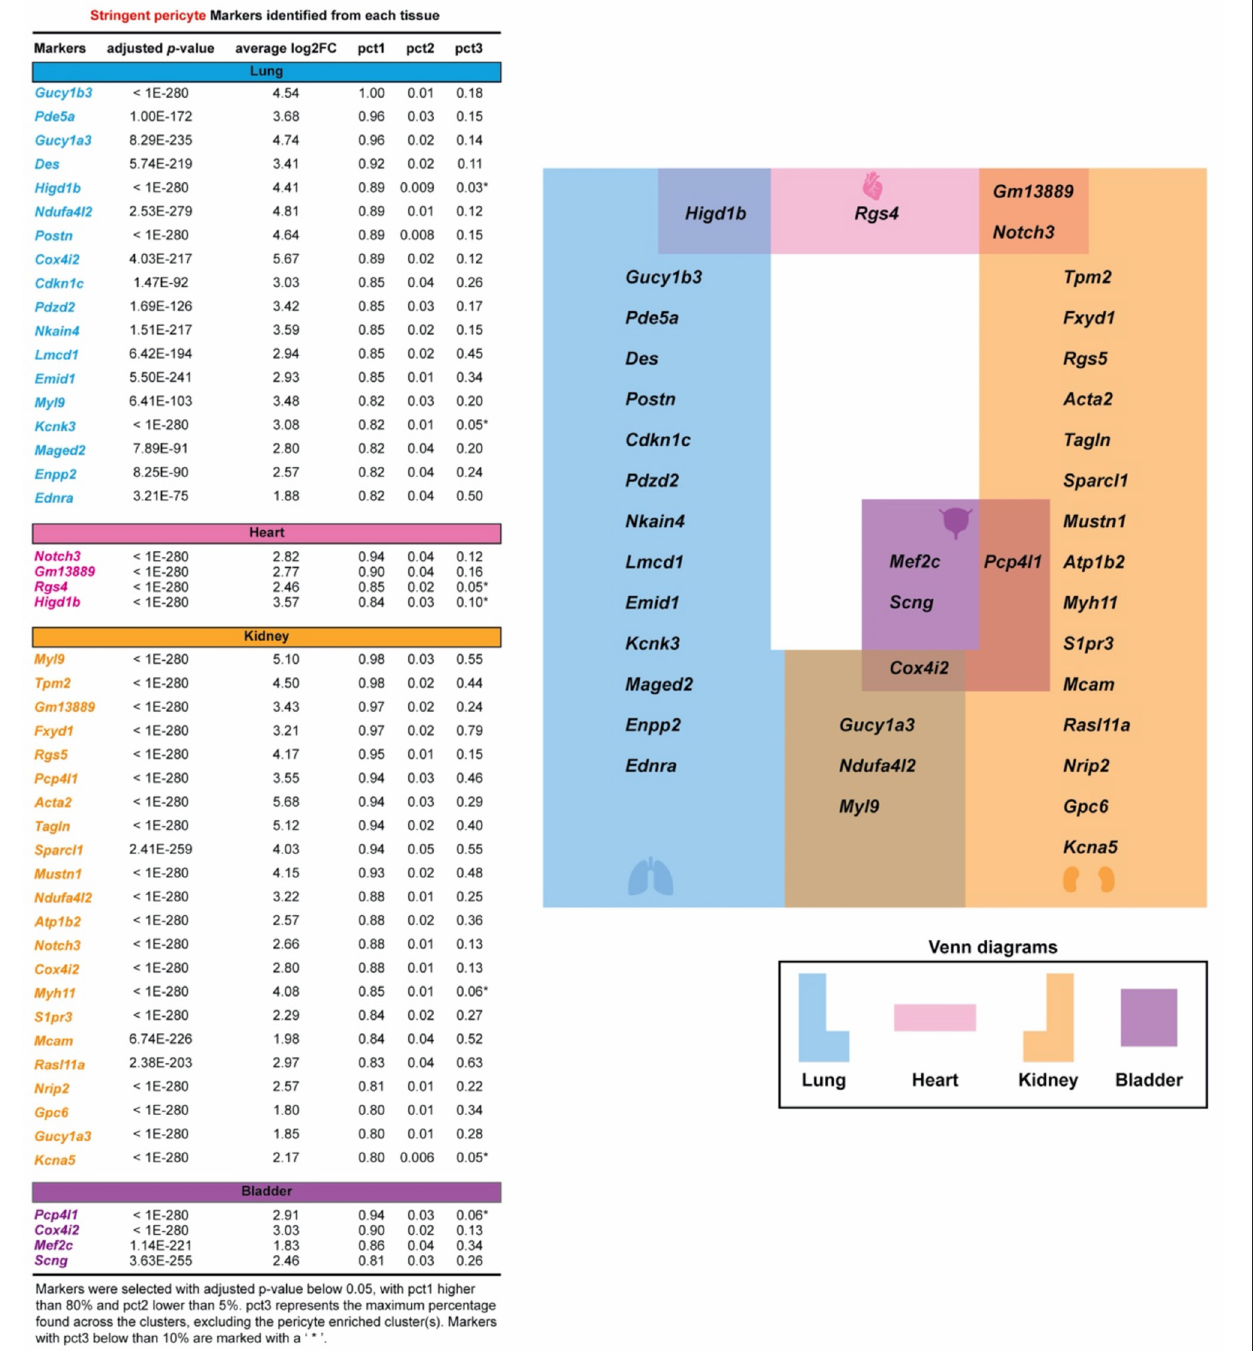
Frontiers in Cardiovascular Medicine | www.frontiersin.org